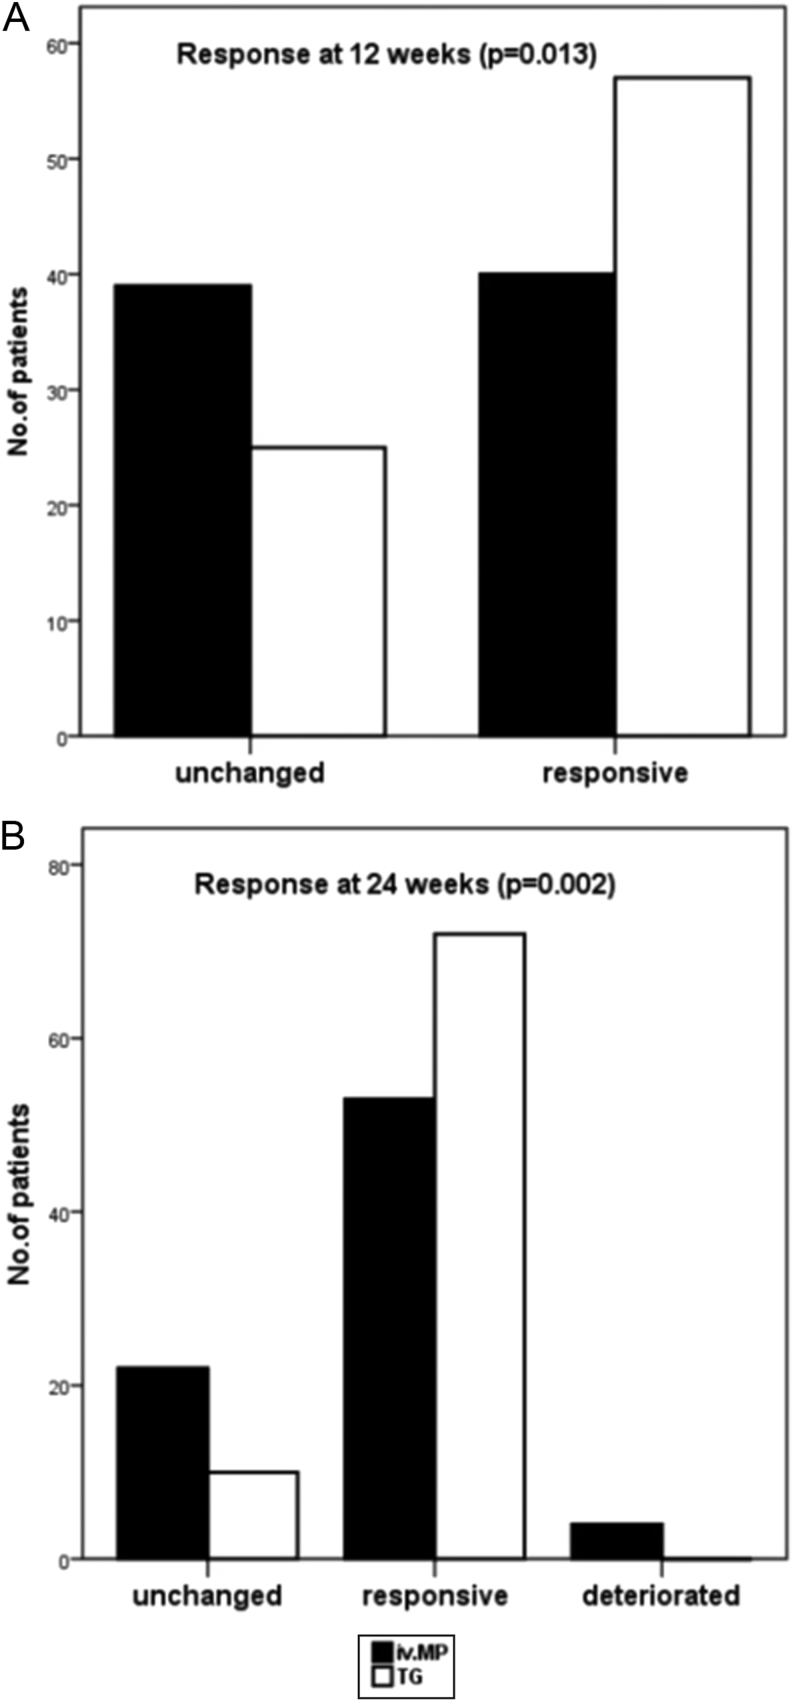
Proportion of patients in the overall response to TG or iv.MP treatment at the 12th and 24th weeks (A and B). The overall responsive was defined as at least four of the following outcome measures: (i) improvement in CAS by 2 or more points or disease inactivation (CAS ≤ 3); (ii) improvement in soft tissue involvement by one grade; (iii) reduction in proptosis by at least 2 mm; (iv) improvement of at least 8° in eye muscle motility (disappearance or reduction in severity of decreased eye movements); (v) improvement in diplopia (disappearance or reduction in severity); (vi) increase in visual acuity ≥2/10; (vii) reduction in lid width by at least 2 mm; (viii) reduction in intraocular pressure by at least 2 mmHg, respectively.